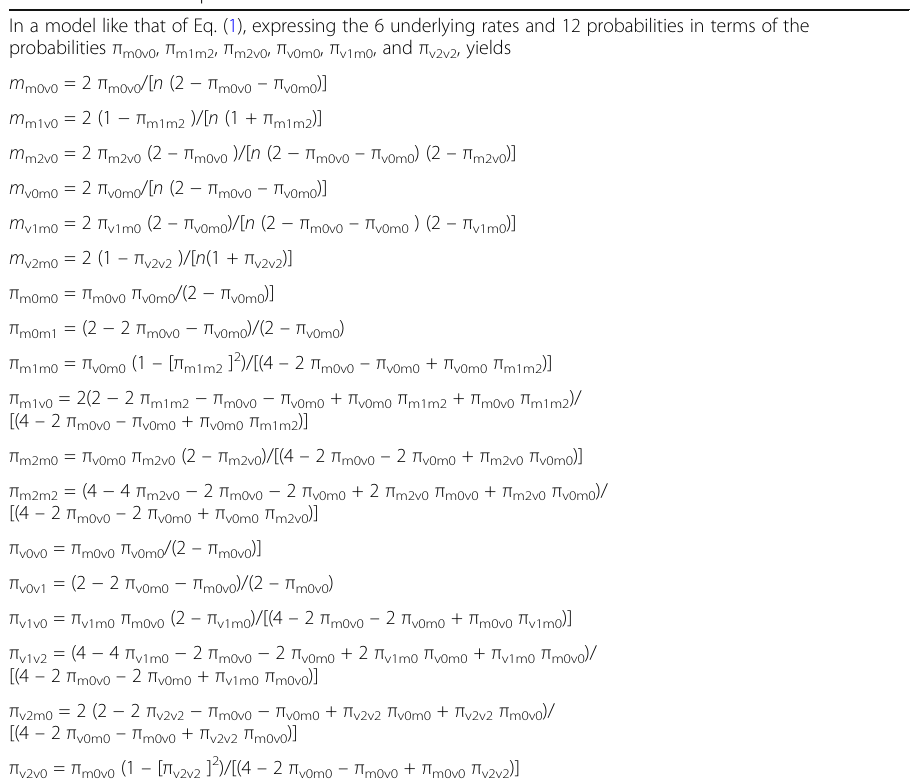
Table 2 Expressions for 6 rates and 12 probabilities in a 2-state, 3-duration semi-Markov model in terms of the other 6